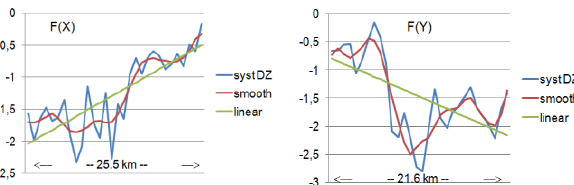
Fig. 14: Systematic height errors of WorldDEM as function of X and Y shown as mean for each distance group in blue, smoothened function in red and as linear function in green for the whole area